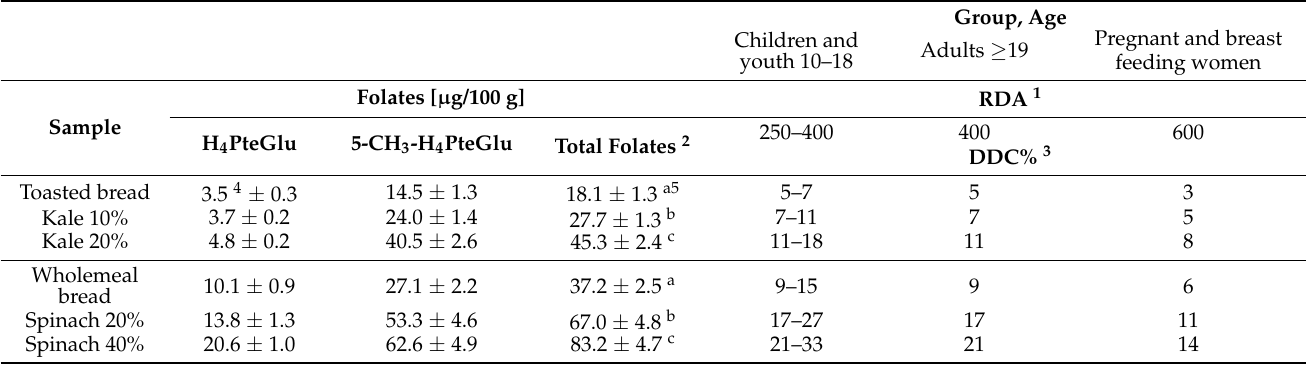
Table 4. The folate content in the tested breads and the coverage of the daily demand for folates after eating a 100 g portion of bread in various population